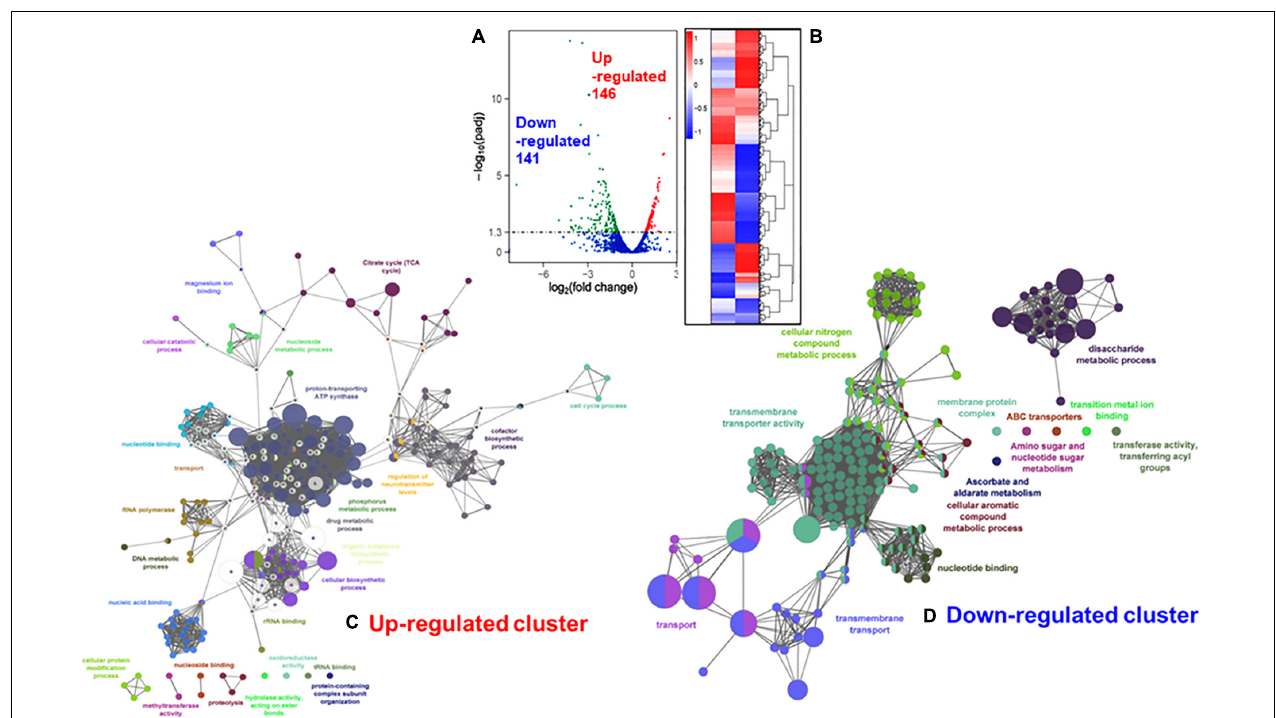
FIGURE 4 | Comparison with RNA-seq based differentially expressed genes (DEGs) in M1T1 (cid:49) TyK mutant vs. M1T1 wild-type GAS strain. (A) Volcano plot for DEGs. The X-axis shows the fold change in gene expression between different samples, and Y-axis shows the statistical significance of the differences [-log 10 .(padj/q-value /FDR)]. Significantly up and Downregulated genes are highlighted in red and green dots, respectively. Blue dots denote genes showing no significant differential expression. (B) Cluster Heat MAP of DEGs in M1T1-WT and M1T1 (cid:49) TyK. The adjacent scale shows up or downregulated DEGs in Log 2 values. Statistical evaluation of the RNA-seq data was performed as described in the “Materials and Methods” section. ClueGo- and Cytoscape-based analysis of the clustered (C) upregulated and (D) downregulated